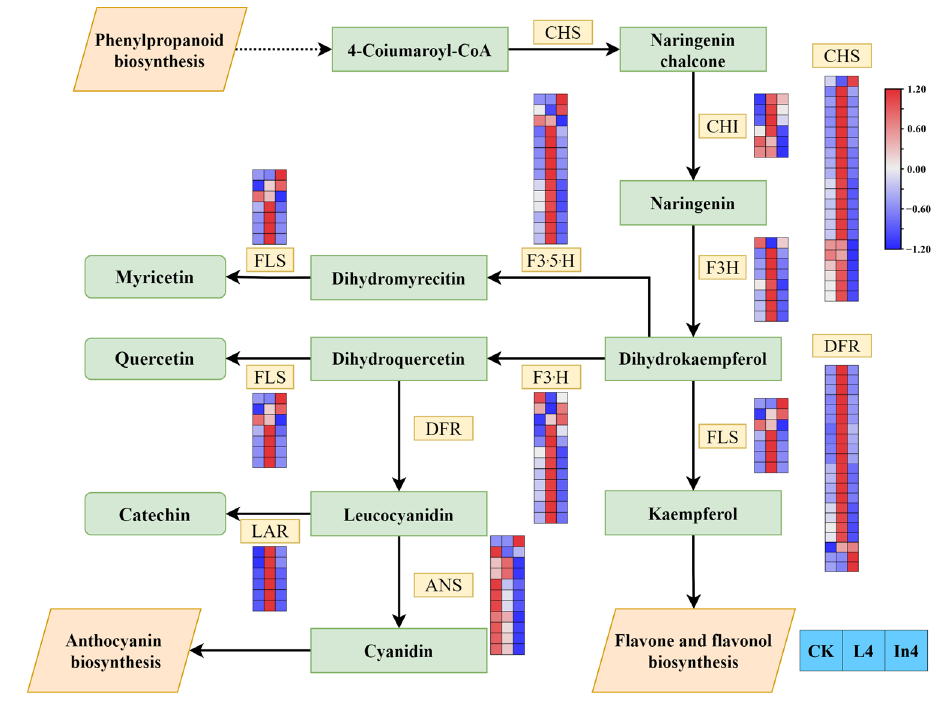
Figure 11. Analysis of DEGs related to flavonoid biosynthesis pathways. The gene expression levels in the three samples are shown in different columns in the colored boxes, and different rows represent different genes. CK: Control. L4: Supplementary LED for 4 h. In4: Supplementary incandescent lamp for 4 h. The color scale from Min (blue) to Max (red) refers to the expression value from low to high.